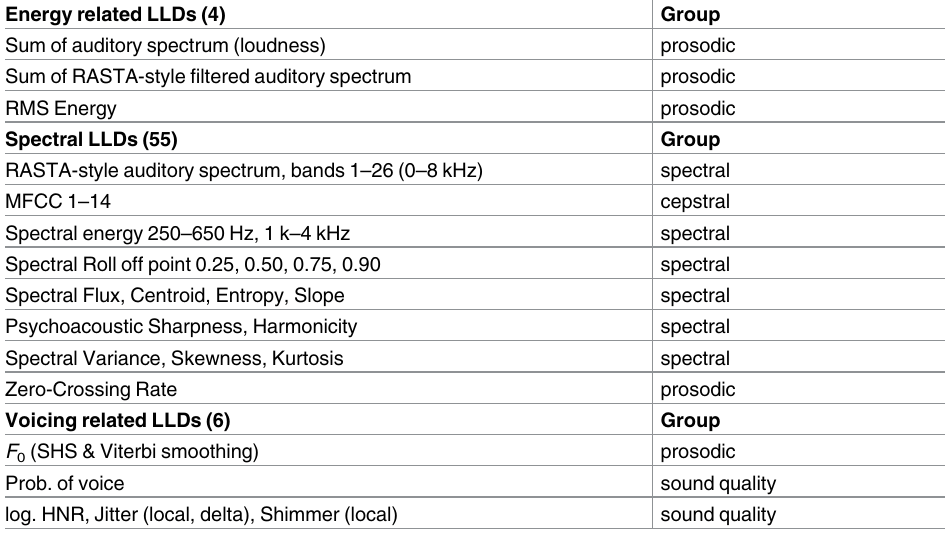
Table 1. ComParE feature set: List of 65 energy-, spectral- and voicing-related low-level descriptors (LLD). Energy related LLDs (4)